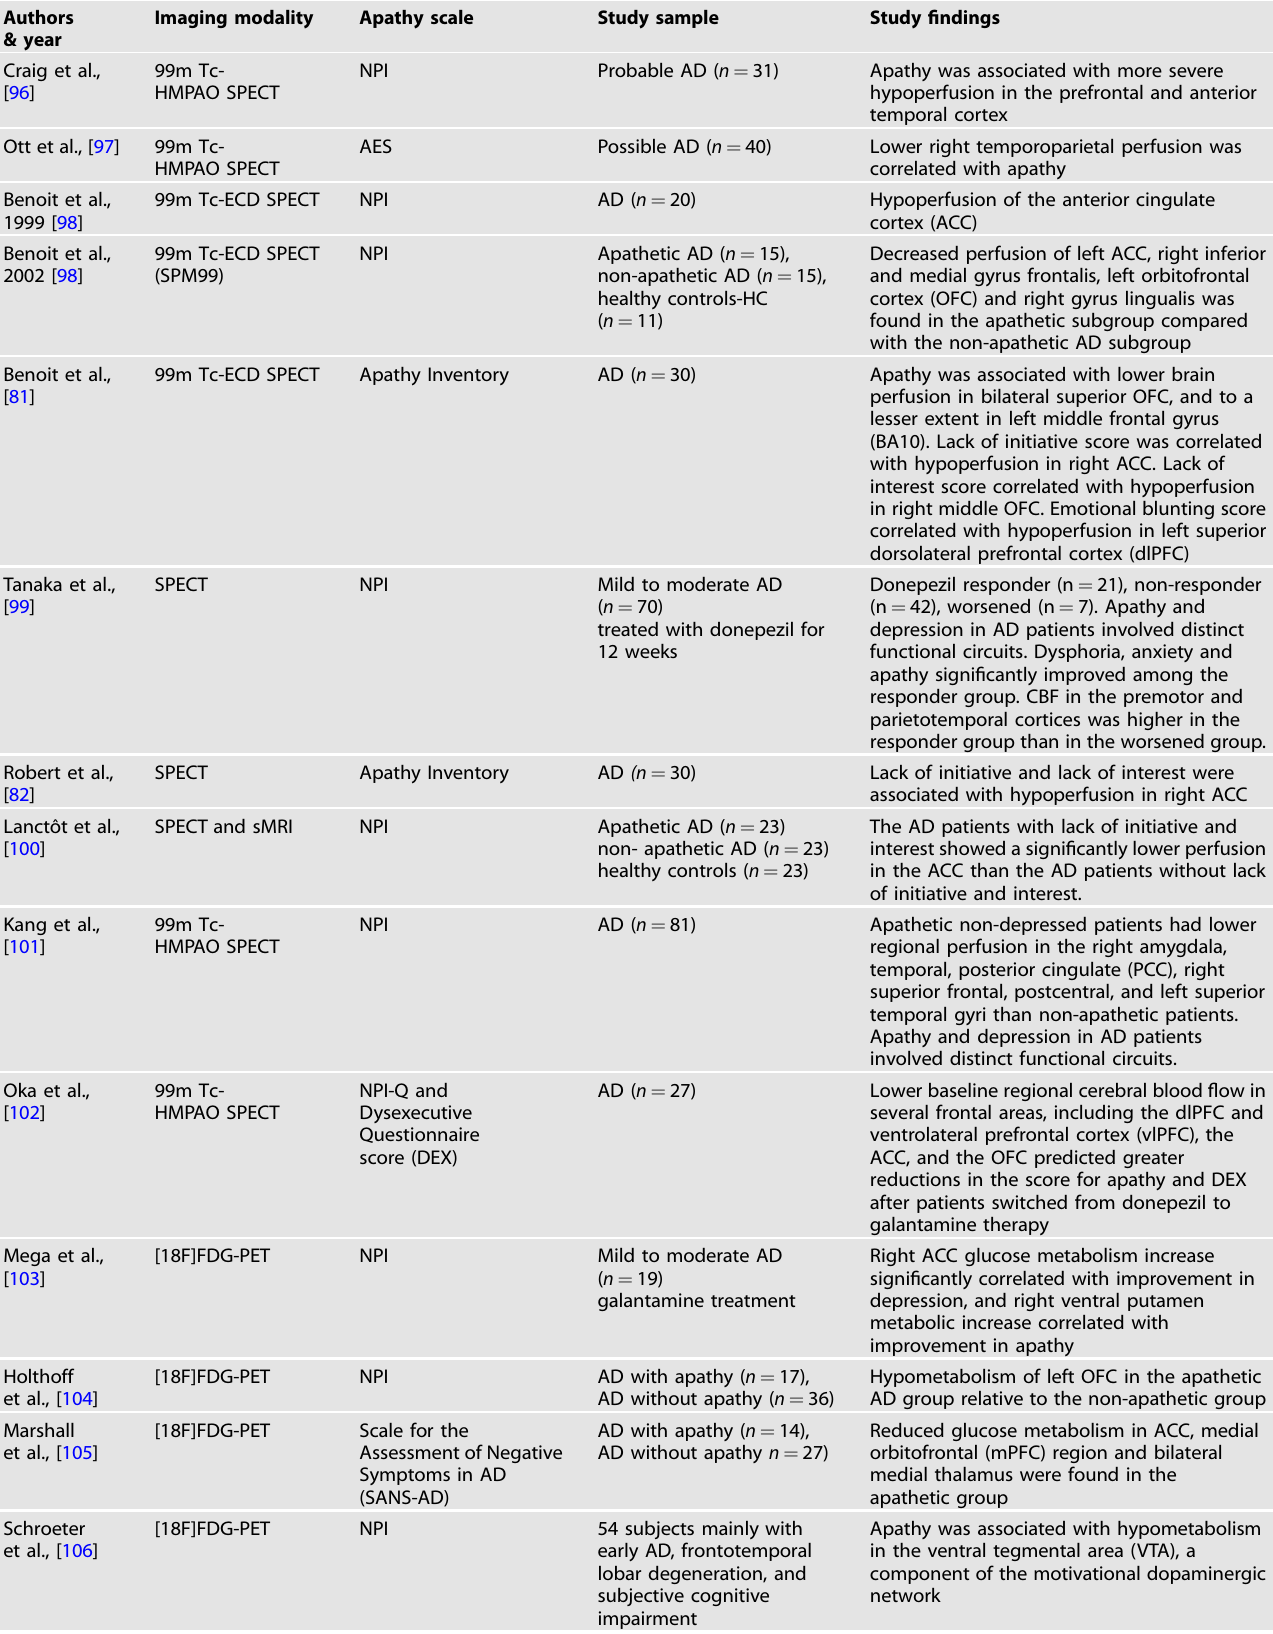
Table 3. Neuroimaging studies of apathy in Alzheimer ’ s disease